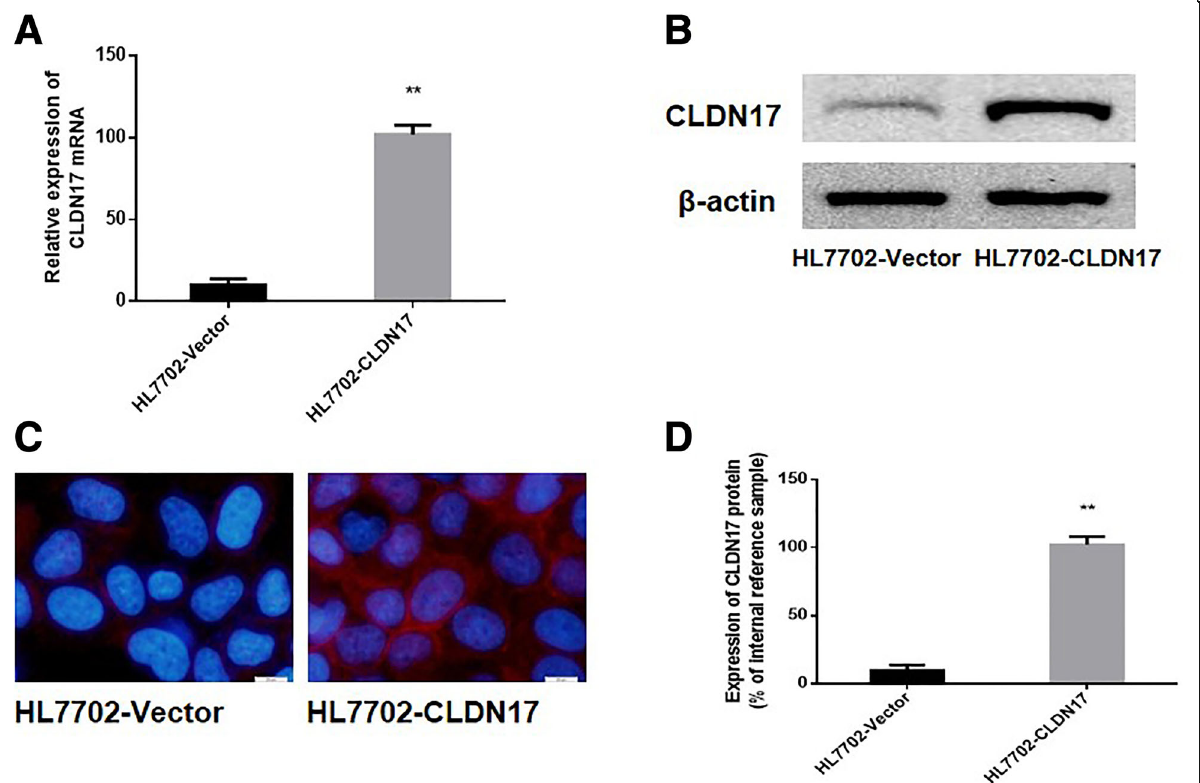
Fig. 2 Characterization of the stable expression level of CLDN17. a Detection of CLDN17 in the HL7702 cell line by real-time PCR; ( b ) Detection of CLDN17 expression in the HL7702 cell line by western blotting; ( c ) Detection of CLDN17 expression in the HL7702 cell line by immunofluorescence; ( d ) The corresponding statistical analysis of protein expression in the HL7702 cell line. Note: * represents P <0.05, and ** represents P <0.01 compared with the empty vector